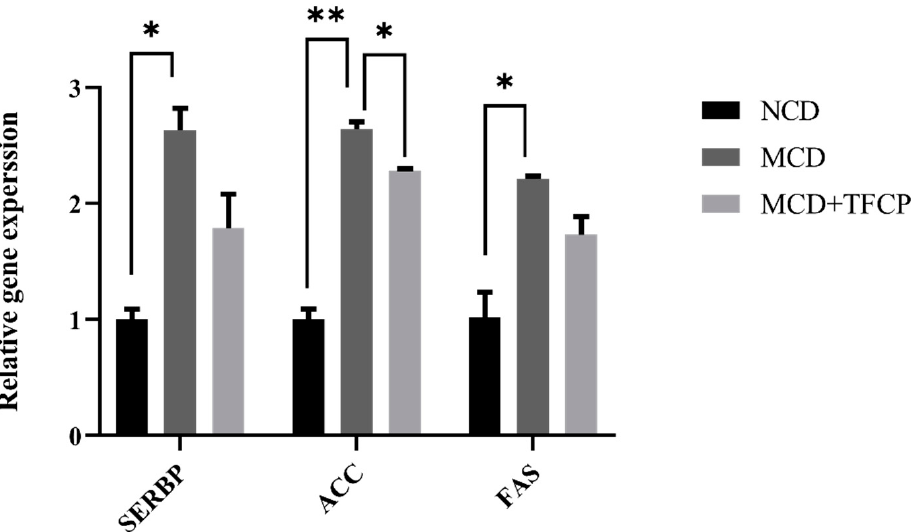
Figure 4. TFCP suppressed the lipid synthesis in the livers of MCD-fed mice. Mice were fed with MCD or the control diet for six weeks, while the intragastric administration of TFCP to MCD-fed mice was performed daily. The mRNA levels of SREBP, ACC, and FAS genes were measured by qPCR. The means ± SEM of the results in the graph were obtained using NCD ( n = 5), MCD diet-fed ( n = 5), and MCD + TFCP-treated ( n = 5) group. Data were shown as the mean ± SEM (** p < 0.01, * p <